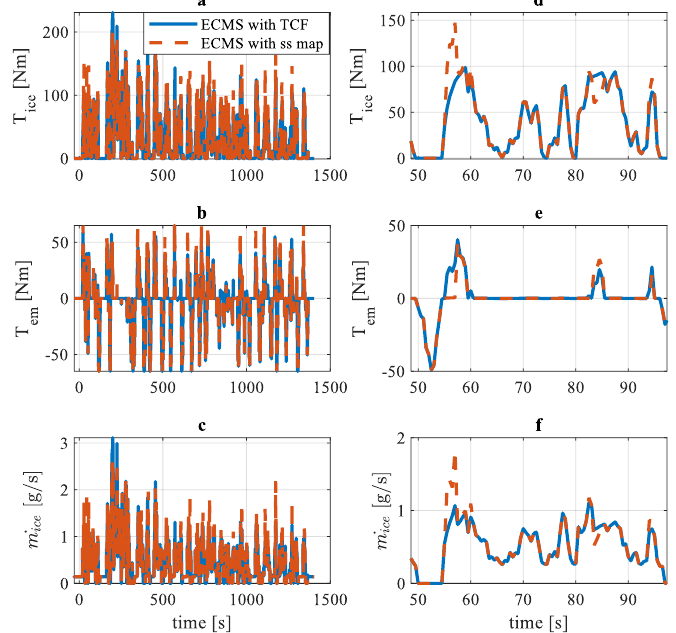
Figure 9. Comparison of engine and EM operations under control of ECMS with/without TCF: ( a ) the engine torque profile, ( b ) the EM torque profile, ( c ) fuel consumption rate of the engine, ( d ) a plot is zoomed in 50–100 s ( e ) b plot is zoomed in 50–100 s ( f ) c plot is zoomed in 50–100.